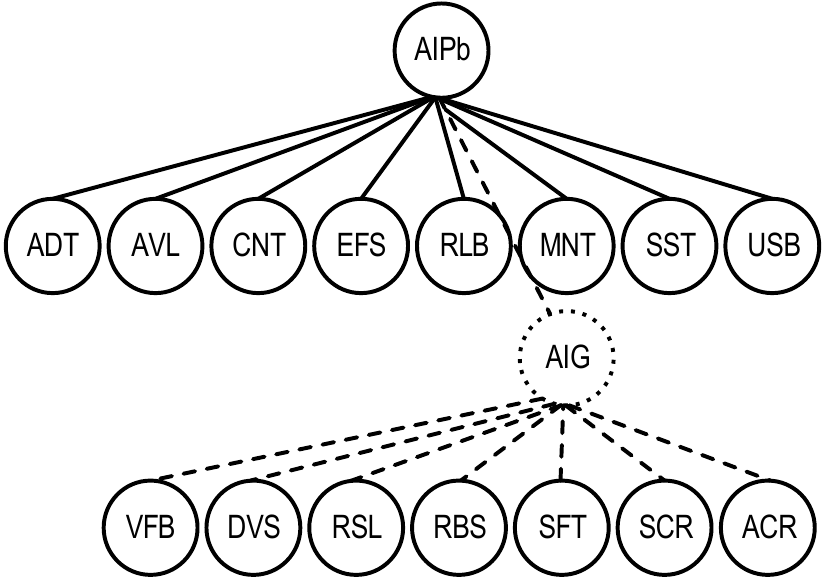
Figure 8. The graph representation of the basic AI platform quality model 𝑄𝑆